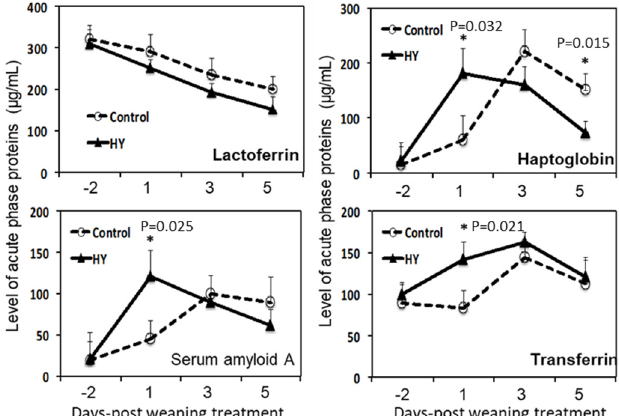
Figure 3. E ff ects of HY supplementation in calf starters on changes in the acute-phase protein levels in calves after weaning. The dotted lines represent the calves fed calf starter without HY (control diet (CON)), and the solid lines represent the calves fed calf starter supplemented with hydrolyzed yeast (HY). The levels of acute-phase proteins in the blood were assessed via an ELISA assay. The asterisks indicate significant di ff erences between the dietary groups ( p < 0.05). Data are presented as the mean ± SE. Day 0 post-weaning represents the beginning of the weaning procedure (42 days of